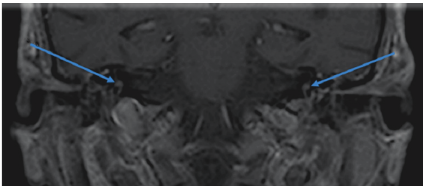
Figure 4: Coronal T1 spin echo showing abnormal bilateral postcontrast enhancement within the vestibule and semicircular canals.